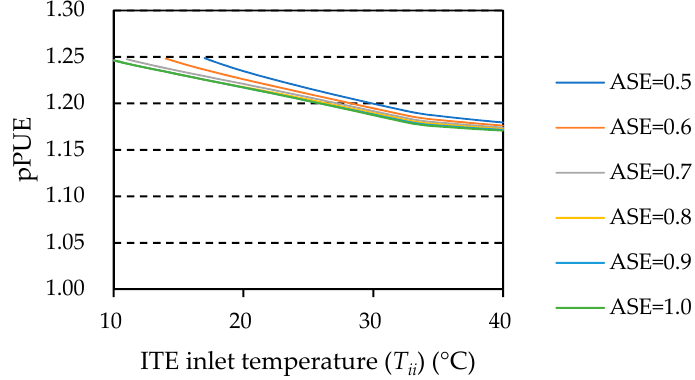
Figure 24. Partial power-usage effectiveness (pPUE) versus ITE inlet temperature ( T ii ).